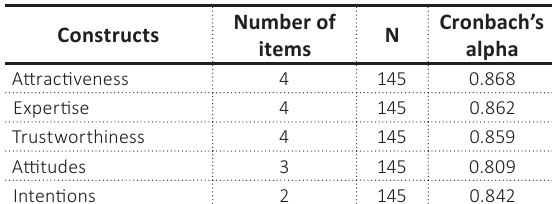
Table 1. Demographic characteristics of the